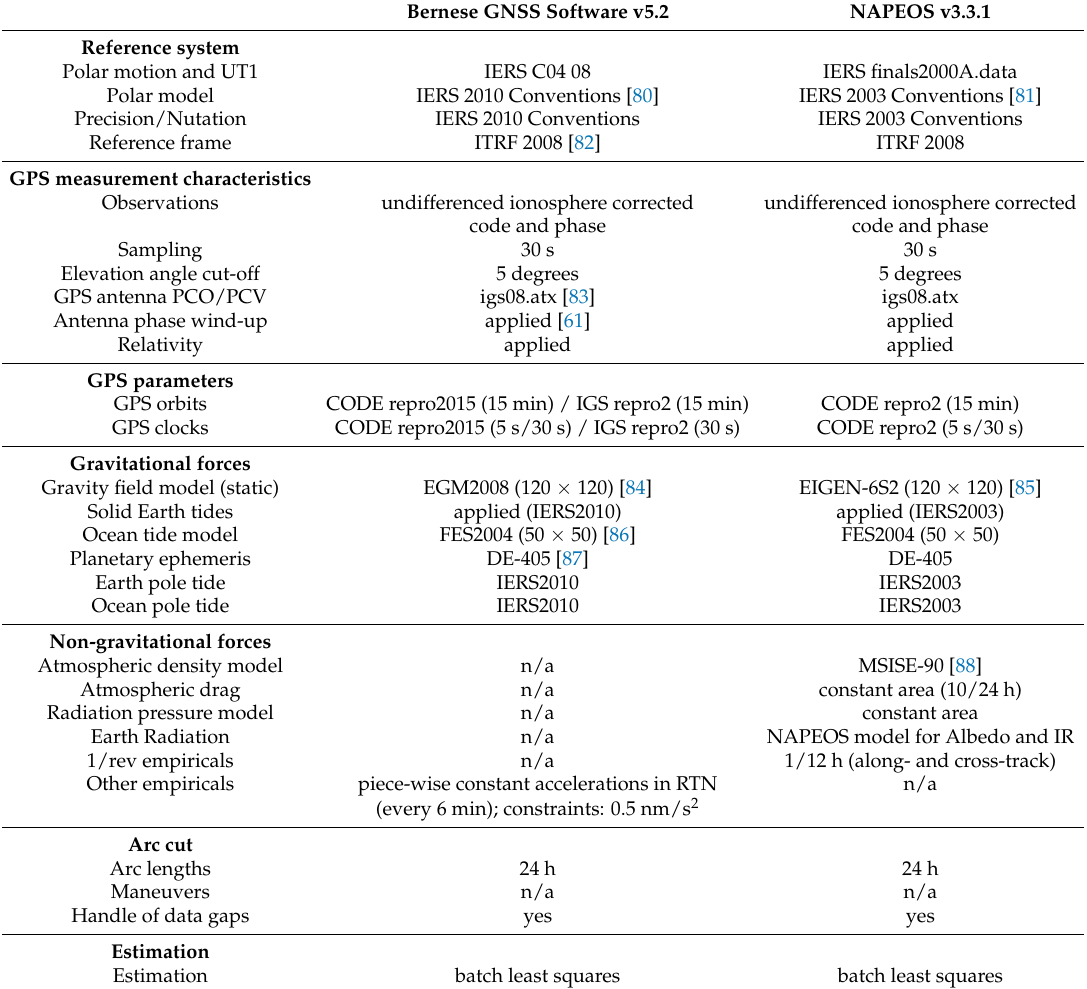
Table 1. Summary of orbit processing models, parameters, and data. For more detailed descriptions see the references cited herein and the sofware documentations